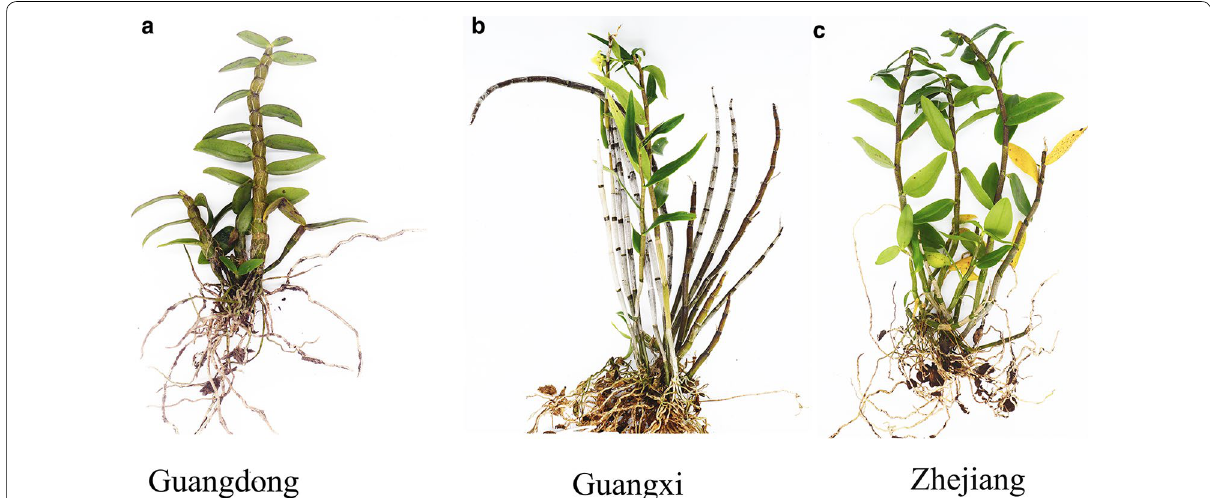
Fig. 1 The pictures of the medical plant, Dendrobium officinale. a Collected from Danxia landform area (Guangdong), b collected from Guangnan area (Guangxi), c collected from Zhejiang